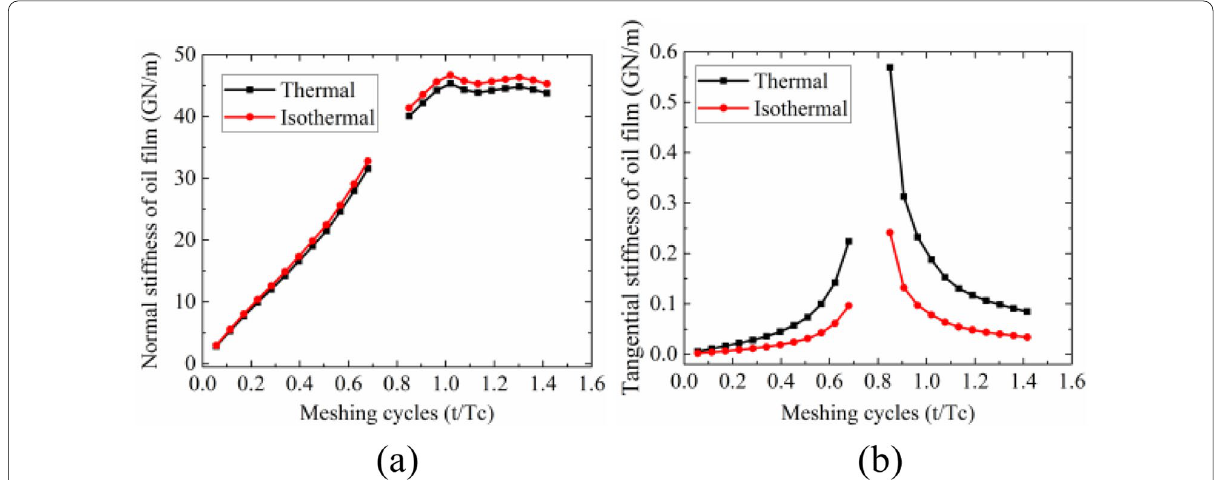
Figure 16 Oil film stiffness of double involute gears in thermal and isothermal